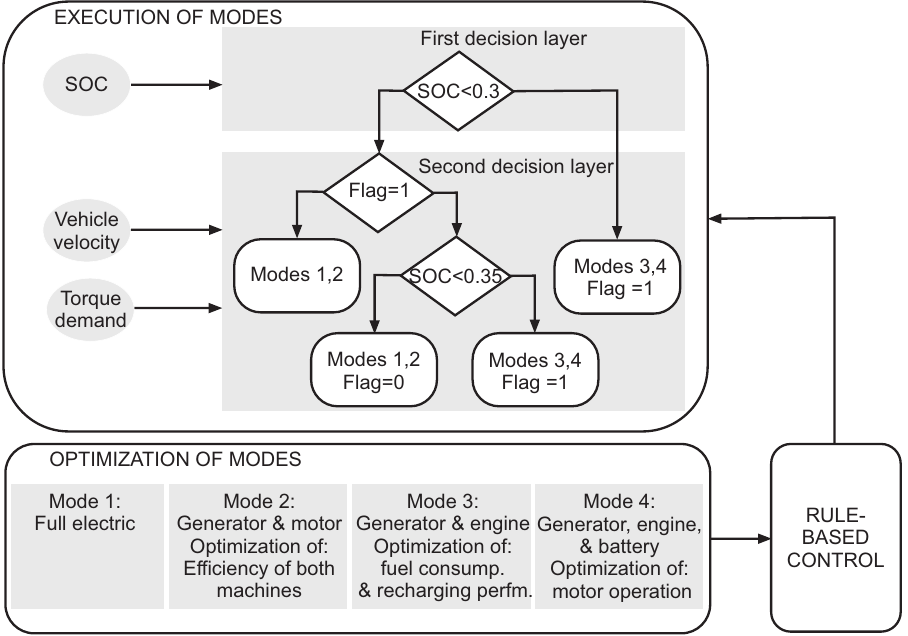
Figure 1. Rule-based controller for mode selection (according to